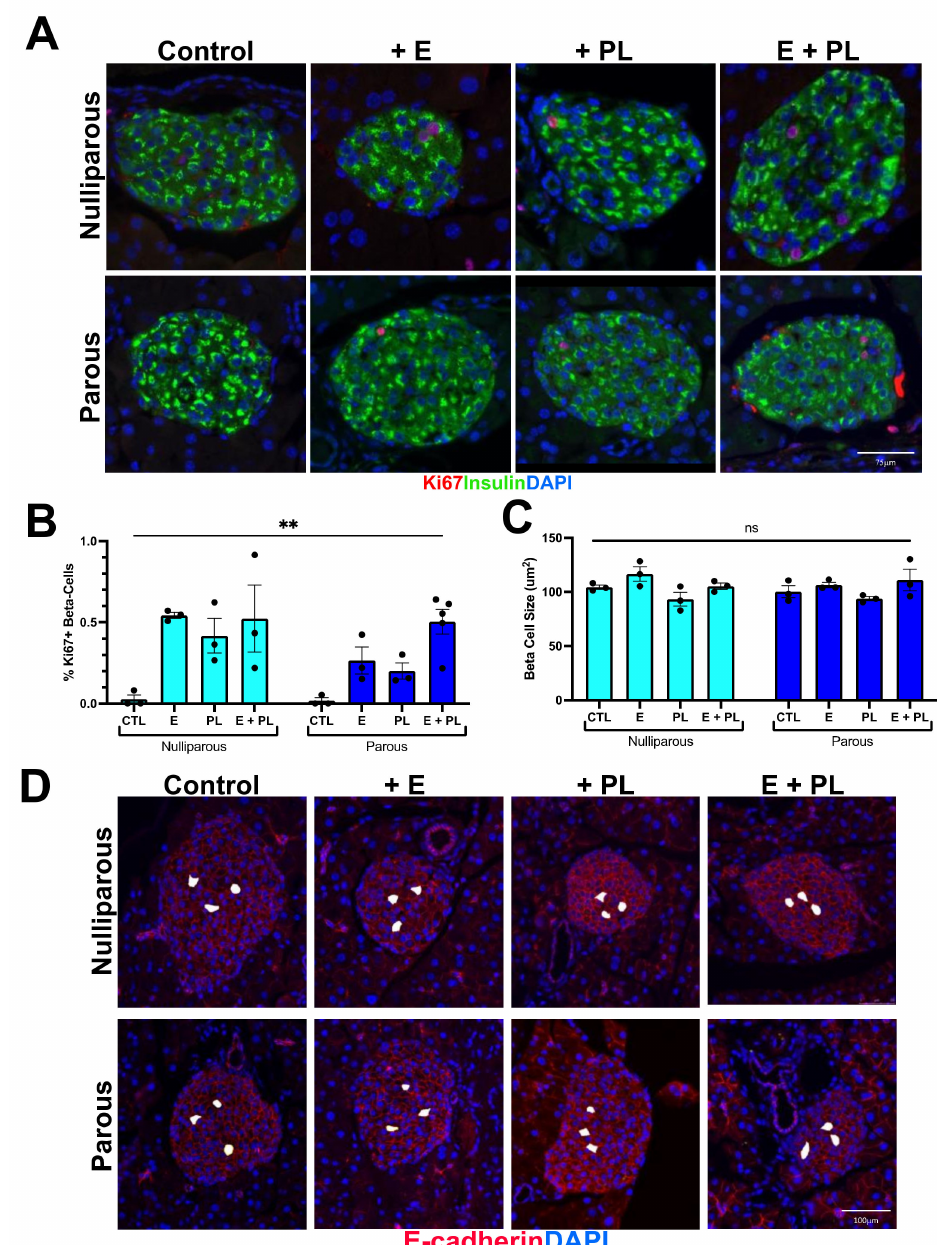
Figure 2. Pregnancy hormones induce beta cell proliferation but not hypertrophy in mice. ( A ) Im- munohistochemical staining for the replication marker Ki67 (red) and insulin (green) at 20 × mag- nification. ( B ) Statistical analysis of Ki67+ beta cells; n = 3–5, ** p = 0.01 using Kruskal–Wallis non-parametric test. ( C ) No change (ns) in beta cell area was found in any group; ANOVA p = 0.09, n = 3. ( D ) Islets stained with E-cadherin; white blocked cells represent beta cell area quantification method (see methods